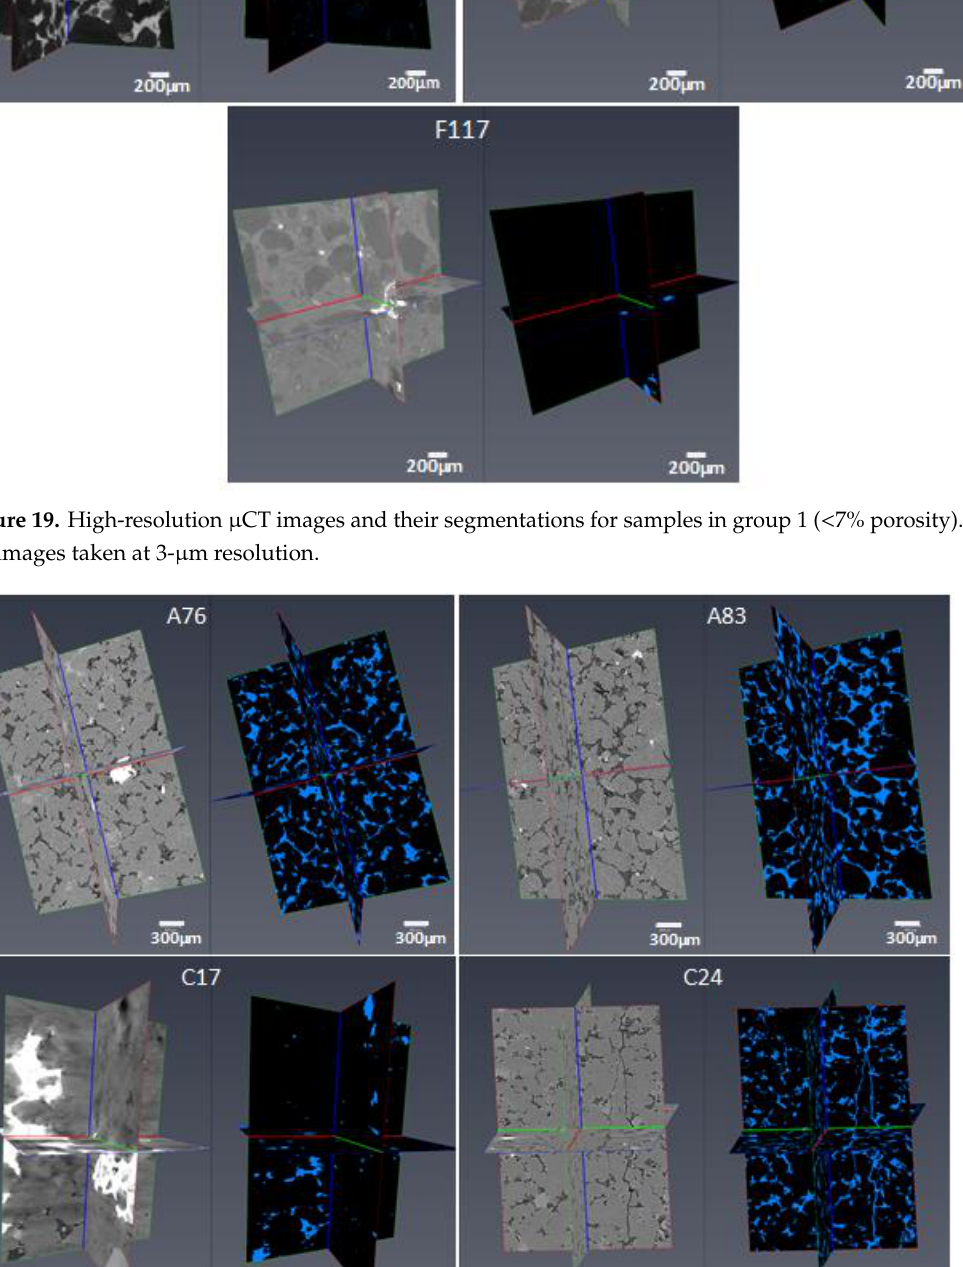
Figure 21. Pore throat size distribution in the range of 1 – 20 µm. On the y-axis is the count (frequency) and the x-axis is the corresponding equivalent radii (EqRadius in µm) of the pore throats.